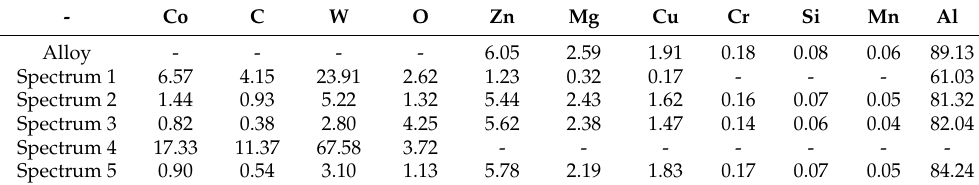
Figure 13. ( a ) SOM image (40×) of the tool flank face, for v c = 40 m/min, f = 0.20 mm/rev and R1; ( b ) EDS Spectrum analyzed point. Table 4. Spectrum composition (wt%).